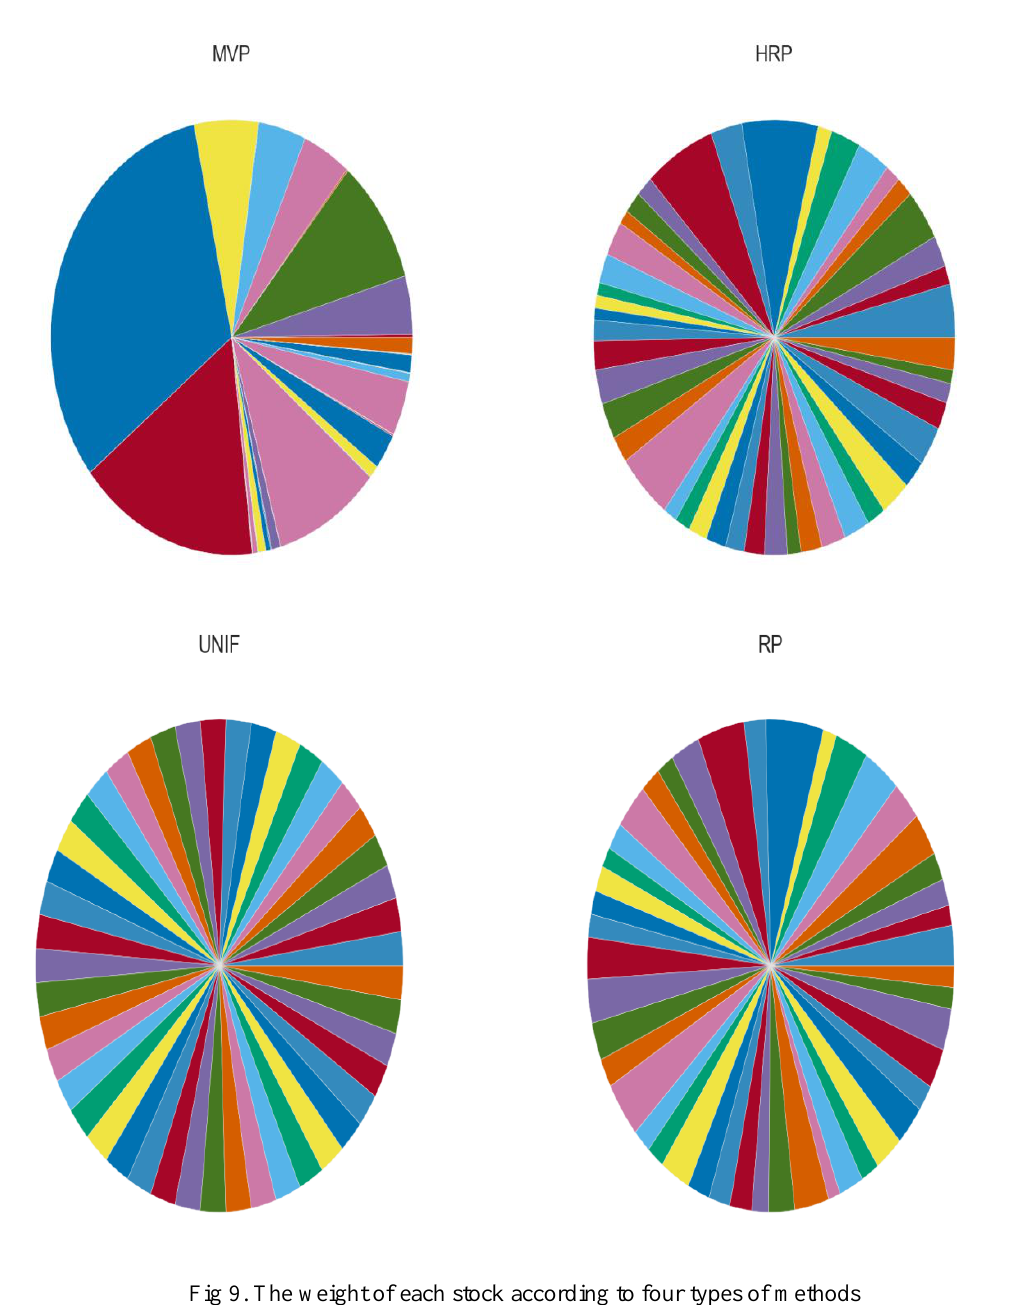
Fig 9. The weight of each stock according to four types of